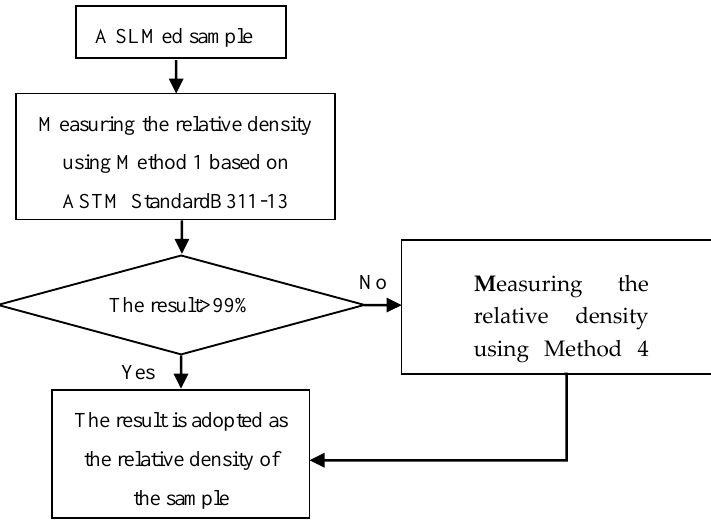
Figure 4. The procedure of method 4*using Archimedes’ Principle.